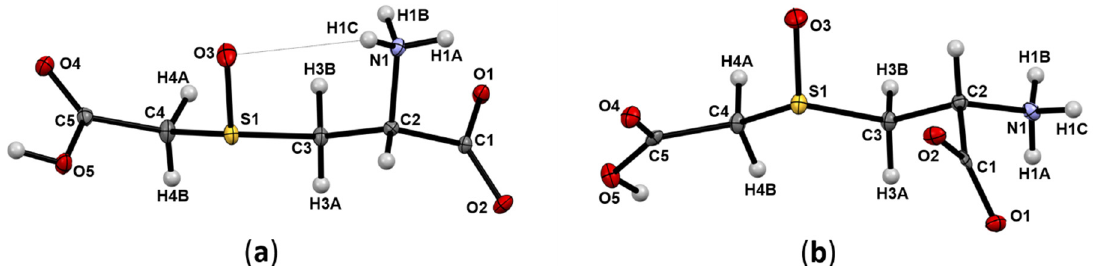
Figure 1. Figure 1. Atom numbering and displacement ellipsoids at 50% probability level for (2 R ,4 R )- S -carboxymethylcysteine sulfoxide polymorphs crystallized in: ( a ) the triclinic space group; ( b ) the orthorhombic space group. An intramolecular hydrogen bond is shown as a thin dotted line.